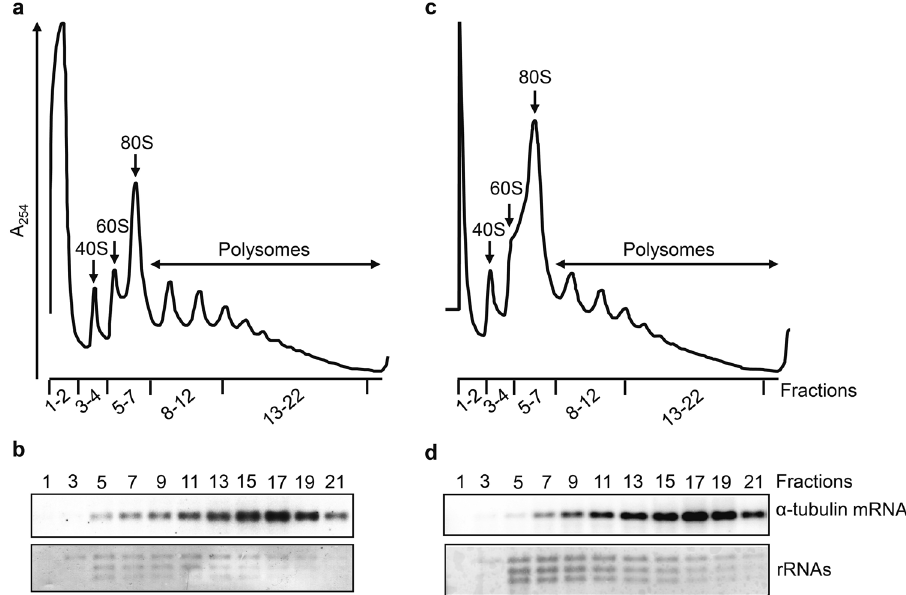
Figure 1. Polysome profiling. ( a , c ) Representative sucrose gradient absorbance profiles. Lysates obtained from un-induced ( a ) and 48 h induced ( c ) RBP6 overexpression cells were loaded on a linear 15–50% sucrose gradient and the absorbance was recorded at 254 nm. The positions of 40S, 60S, 80S and polysomes are indicated. The six pooled gradient fractions are: 1–2 (free RNA), 3–4 (40S), 5–7 (60S and 80S)), 8–12 (light polysomes), 13–22 (heavy polysomes). ( b , d ) Northern blot analyses for the polysomal distribution of α-tubulin mRNA of un-induced ( b ) and 48 h induced ( d ) RBP6 overexpression cells. The fraction numbers from the monosomes to the heavy polysomes that were loaded on the gel are indicated. The bottom panel in each shows the methylene blue staining of the large ribosomal RNAs in the sucrose density gradient fractions. Full-length blots of panels ( b ) and ( d ) are shown in Supplementary Fig.